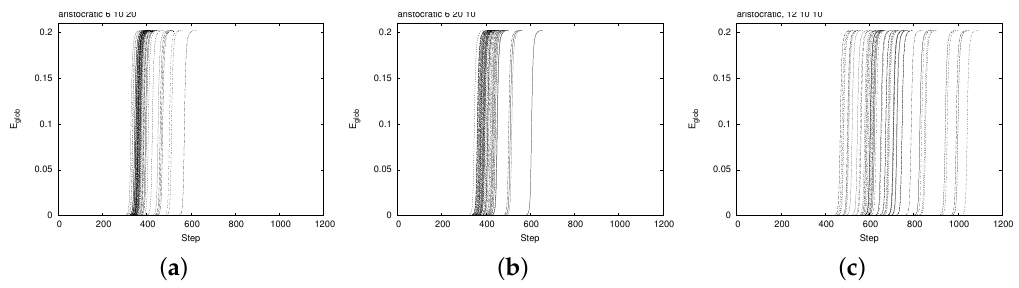
Figure 13. Spread of E glob curves over multiple runs of simulations (aristocratic rule) on the same VT dataset, with same cost configurations: µ = ( 6,10,20 ) in left panel ( a ), µ = ( 6,20,10 ) in center panel ( b ), µ = ( 12,10,10 ) in right panel ( c